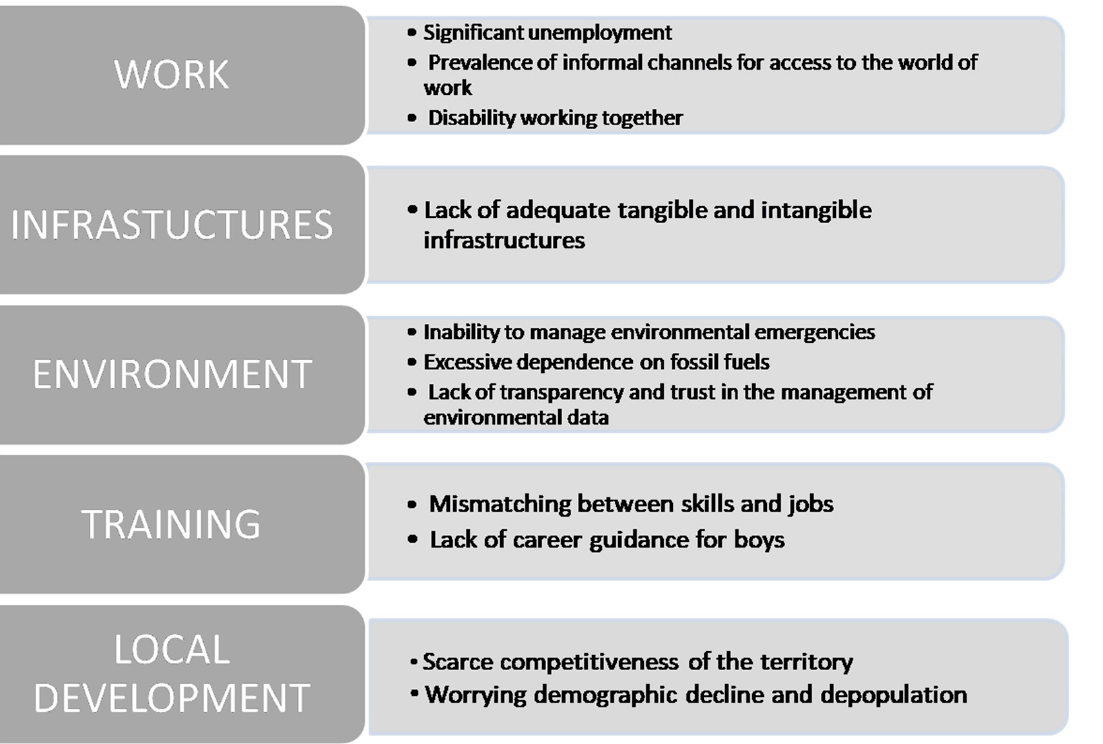
Figure 4. The most felt problems individuated by the territorial survey .